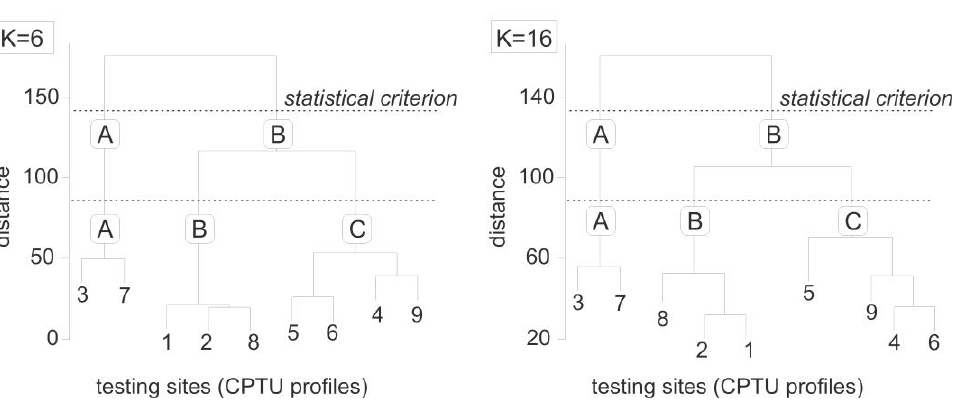
Figure 8: Dendrograms of the clustering hierarchy of curves M = f(z) from the CPTU testing of sites within the range of depth of 2–8 m for the strongly smoothed function ( K =6) and weakly smoothed function ( K